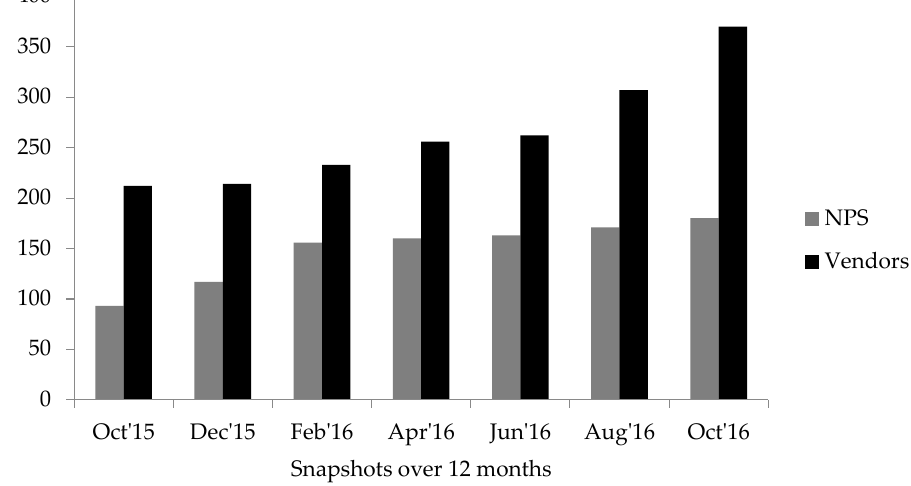
Figure 1. Number of NPS and vendors in each month of data collection (seven snapshots in 12 months) . NPS: New Psychoactive Substances.